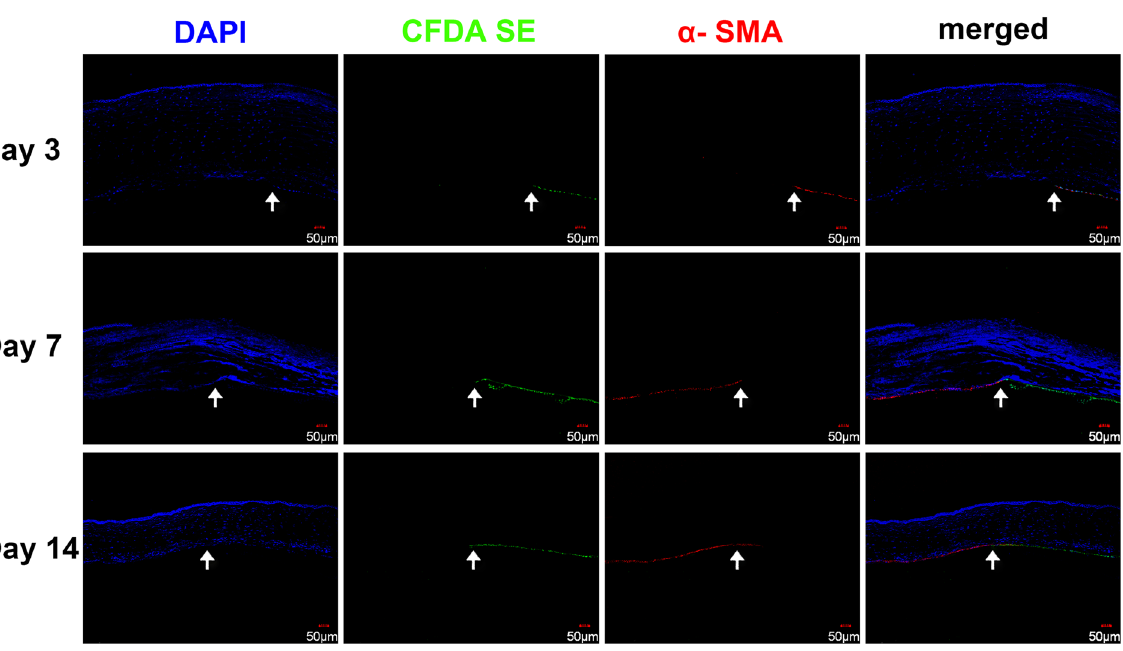
Figure 6. Endothelial cell tracing and α -SMA staining of the cornea after DM stripping. CFDA SE-labeled cells showed minor migration toward the central cornea from day 3 to day 14. Immunostaining showed that some CFDA SE-labeled cells close to the wound edge (arrows) expressed α -SMA on day 3. On day 7, cells on the stromal surface of the surgical site showed positive α -SMA staining, but they were not labeled with CFDA SE. CFDA SE-labeled α -SMA positive cells became negative on day 7. Cells on the stromal surface of the surgical site remained positive α -SMA staining on day 7 and day 14. Bars represent 50 μ